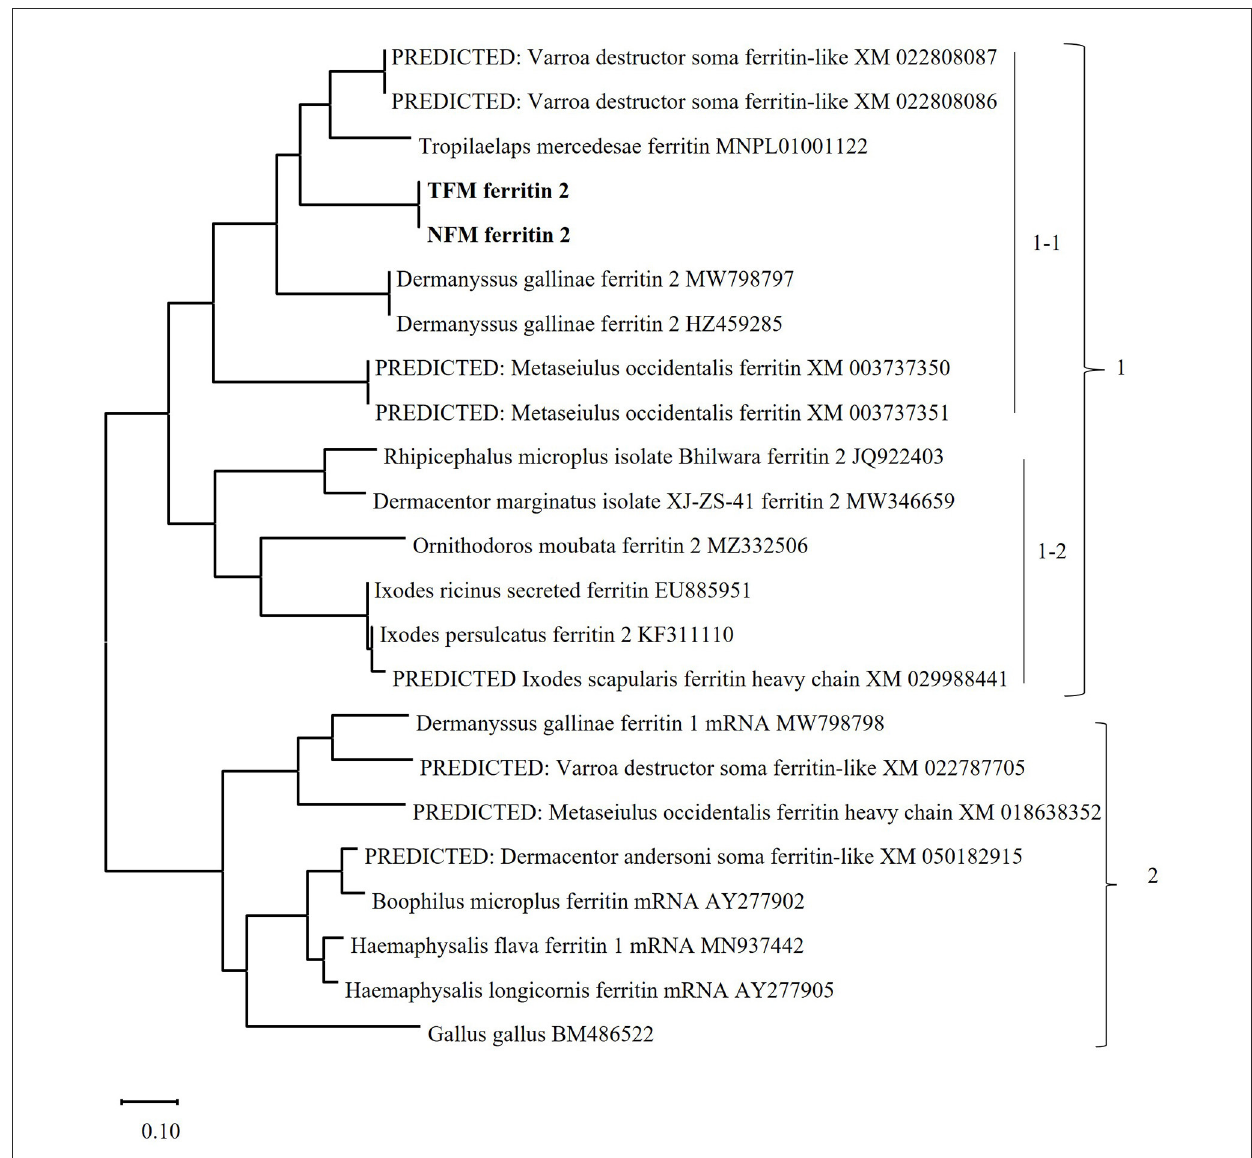
FIGURE1 Phylogenetic analysis of the ferritin ( FER ) genes from poultry red mites (PRM), tropical fowl mite (TFM), northern fowl mite (NFM), arthropods, including other mites and ticks, and chickens. The phylogenetic tree was constructed using the maximum-likelihood method with MEGA X software. The numbers on the right indicate the clusters. Cluster 1 includes secretory types of FER2 genes, and is divided into 2 subclusters. Subcluster 1-1: The secretory types of FER2 genes of mites are classified into this subcluster, and the FER2 genes of PRMs, TFMs (bold), and NFMs (bold) belong to this cluster. Subcluster 1-2: This cluster consist of secretory types of FER2 genes from ticks. Cluster 2: The intracellular FER genes of mites, ticks, and chickens are classified into this cluster.